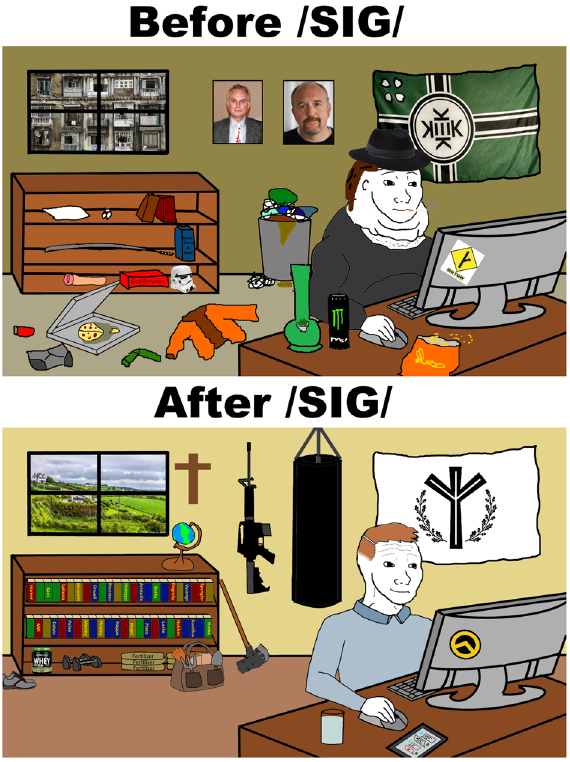
Fig. 1 An image posted in a SIG thread on 22/08/2019. This image, which is regularly posted in SIG threads, shows many of the self-improvement goals that SIG advocates for: in the second panel the character has among other things tidied his room, lost weight, given up drugs, popular culture, and unhealthy food, taken down pictures of Louis C.K. and Richard Dawkins, moved to the country, and taken up reading, exercise, religion and